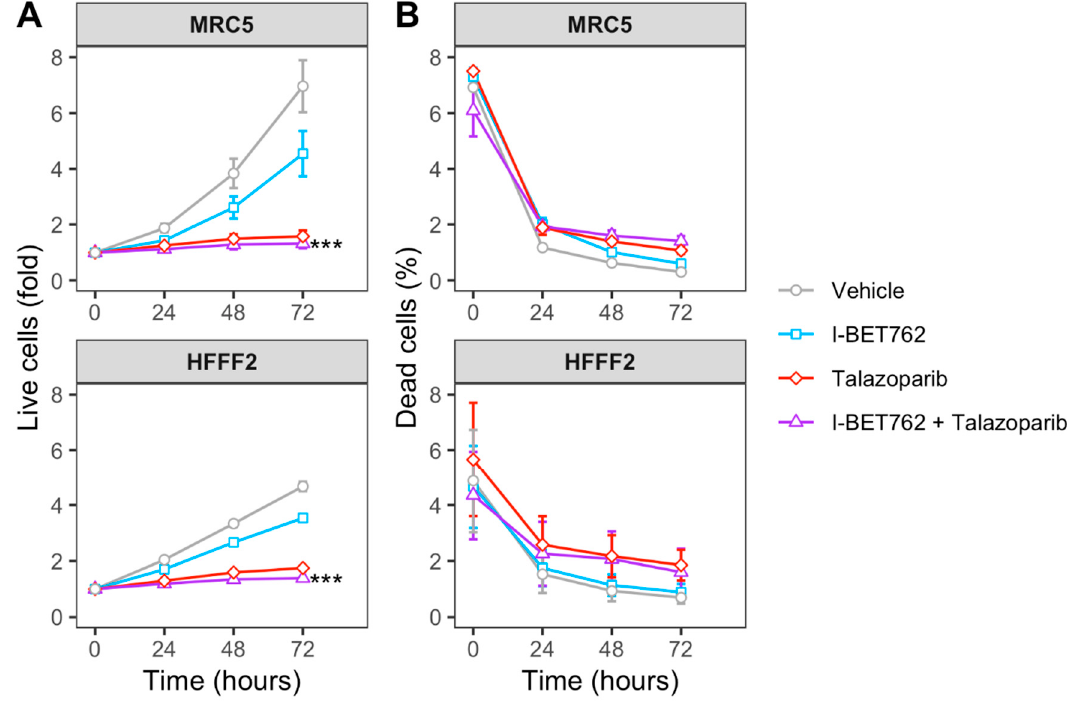
Figure 2. E ffi cacy of I-BET762 and Talazoparib combination on non-tumor cells. ( A ) Timeplot of live cell number in non-tumor fibroblast cell lines HFFF2 and MRC5 that were treated with I-BET762 and Talazoparib as single agents or as a combination. ( B ) Percentage of dead cells. Values shown mean ± SE. Benjamini-Hochberg corrected one-way ANOVA was performed between Talazoparib-treated and drug combination-treated samples, since Talazoparib as single agent showed increased anti-proliferative activity compared to I-BET762. *** p < 0.001 .